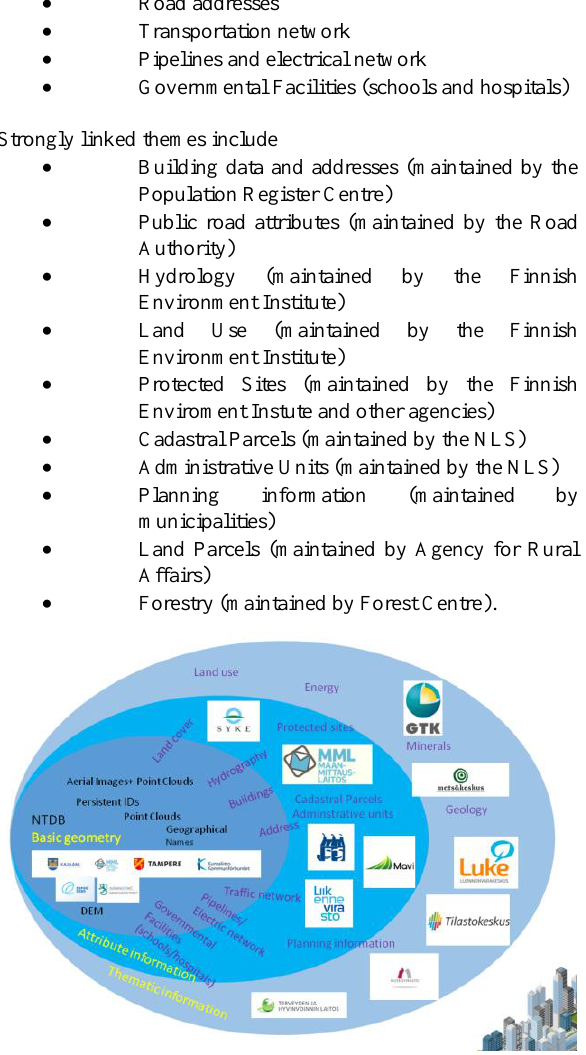
Figure 1 . Content of the NTDB and connections with other governmental agencies and